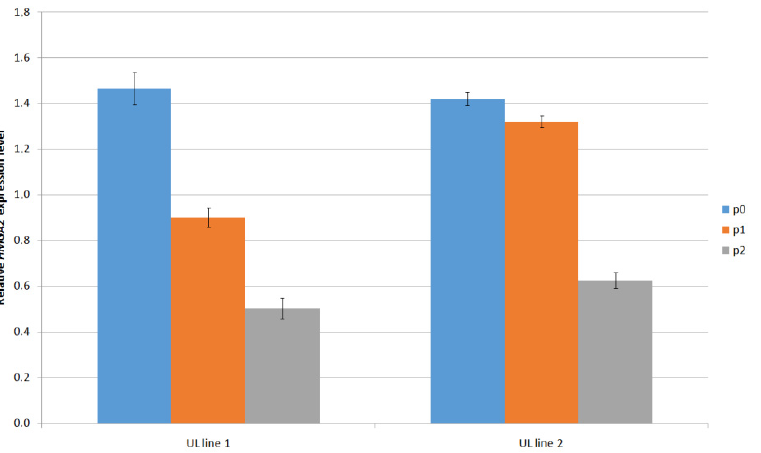
Figure 4. Measurement of HMGA2 gene expression (fold change relative to reference β -actin gene) in two independent primary UL cell lines at different passages.